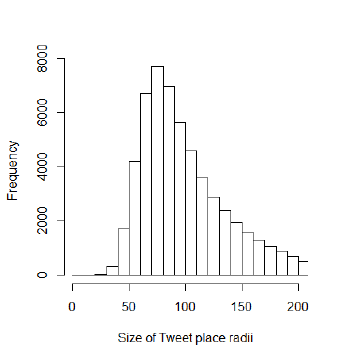
Figure 1: Histogram of the radii of Tweet place clusters